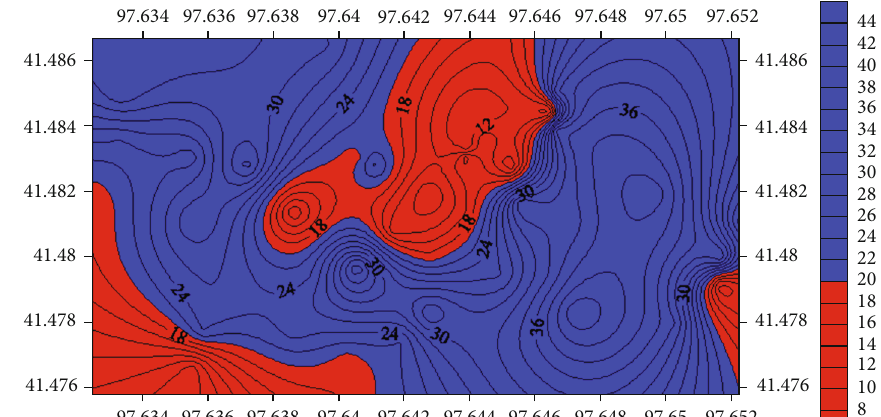
Figure 8: The contour map of RMSG around BS23 borehole.